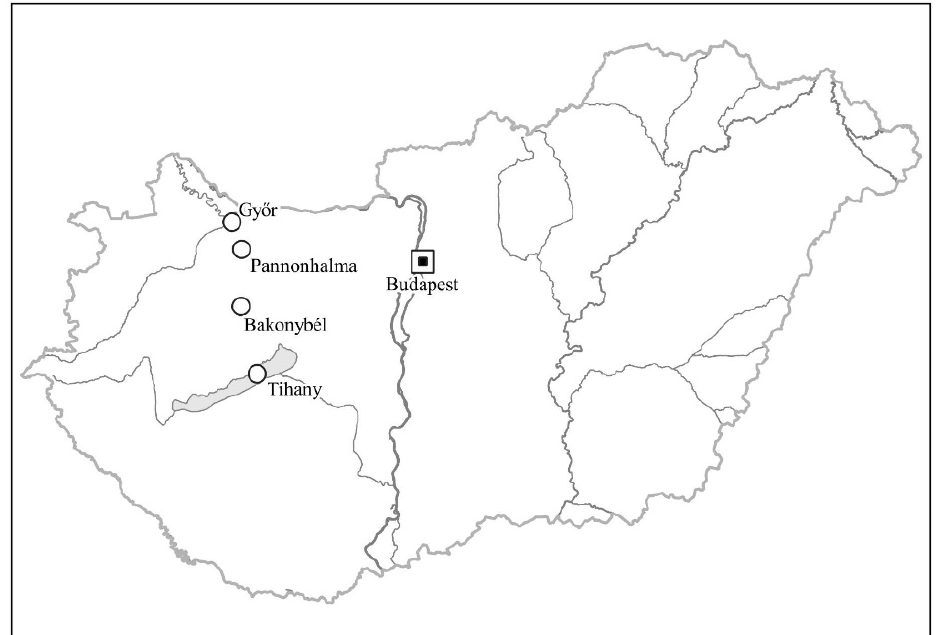
Figure 1. Benedictine Communities in Hungary. Source: Own compilatio.